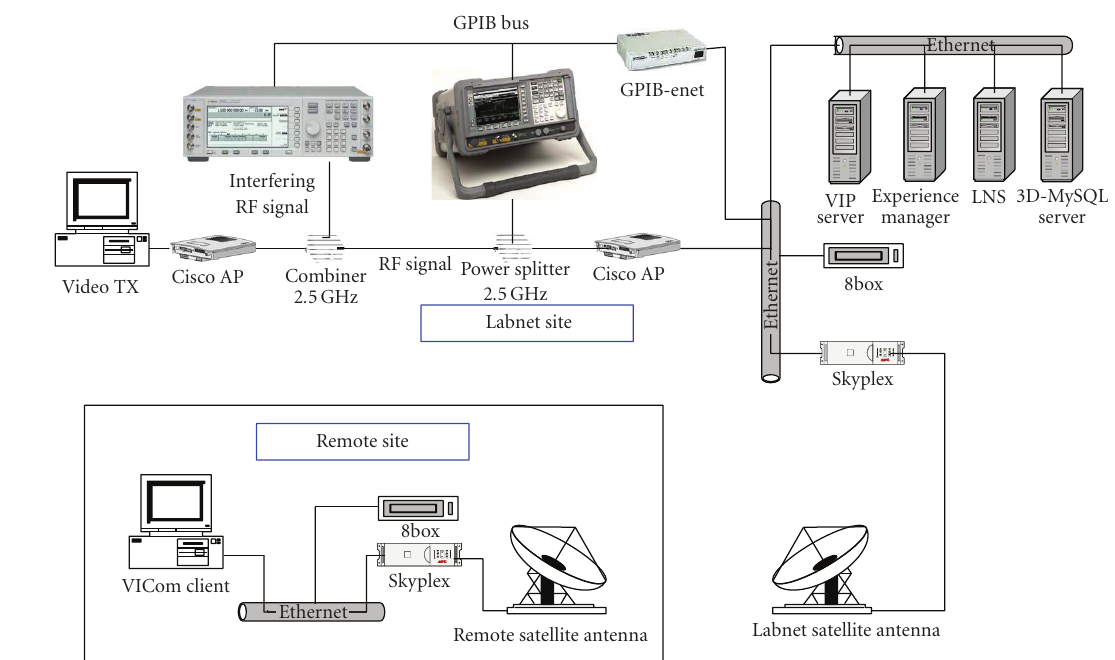
Figure 11: Demo architecture in the many-to-one telemeasurement session.